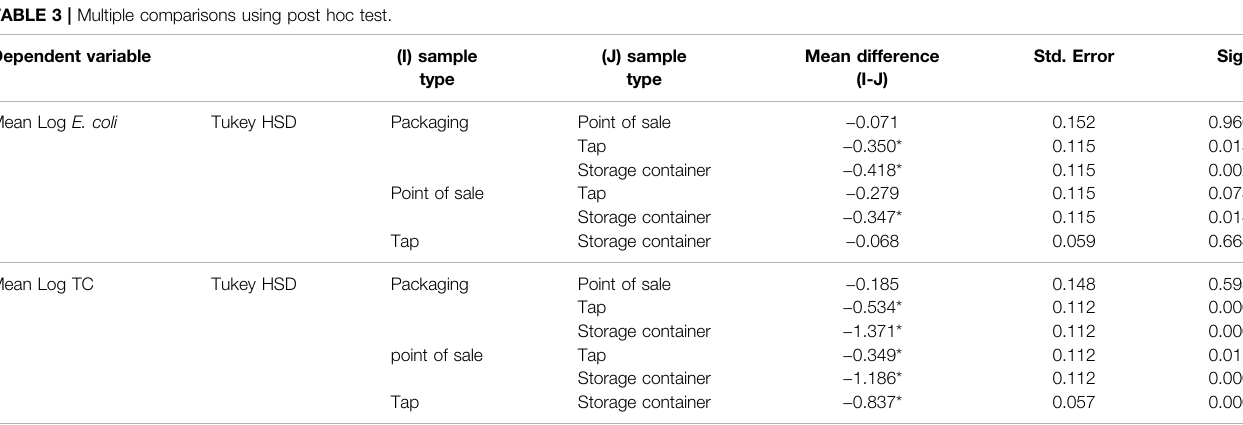
TABLE 3 | Multiple comparisons using post hoc